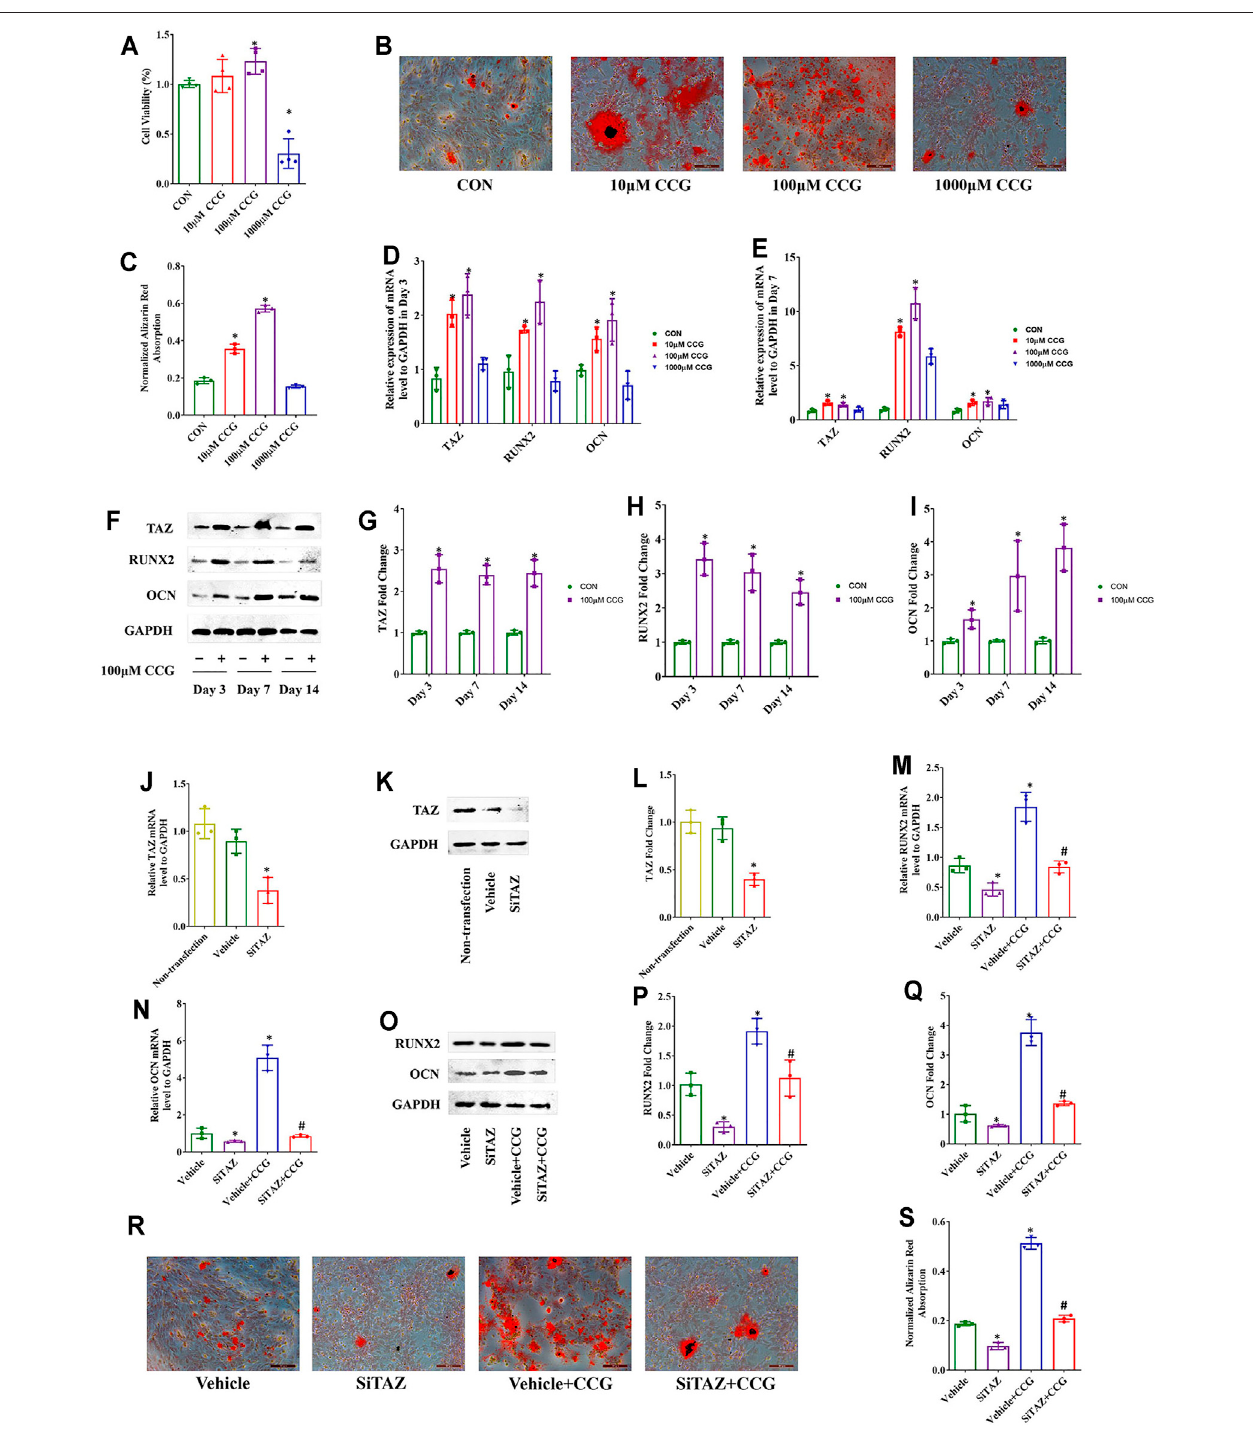
FIGURE 3 | CCG targeted TAZ to facilitate osteogenic differentiation of BMSCs in vitro . (A) MTT assays presented cell viabilities after CCG administration during osteogenesis of BMSCs. (B, C) Representative images of AR-S results in different mice groups. Scale bar: 100 μ m. (D, E) Relative mRNA levels of TAZ, RUNX2, and OCN with or without CCG treatment. (F – I) TAZ, RUNX2, and OCN expression in protein levels with or without CCG treatment. * p < 0.05 vs. the control group. (J – L) SiTAZplasmidsigni fi cantlyknockeddownthemRNAandproteinlevelsofTAZduringtheosteogenesisofBMSCs. (M – Q) SiTAZdiscountedtheCCGinducedup- regulation of RUNX2 and OCN. (R, S) Representative images of AR-S showed the differences of calcium deposits in different groups. Bar graphs showed the means ± SD from three independent experiments. Scale bar: 100 μ m (n (cid:1) 3) * p < 0.05 vs. the Vehicle group; # p < 0.05 vs. the Vehicle + CCG group.